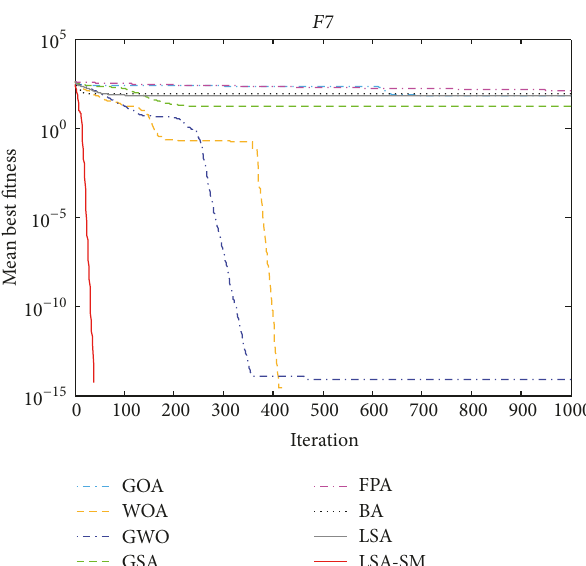
Figure 11: 𝐷 = 30 , convergence curves for 𝑓 07 .